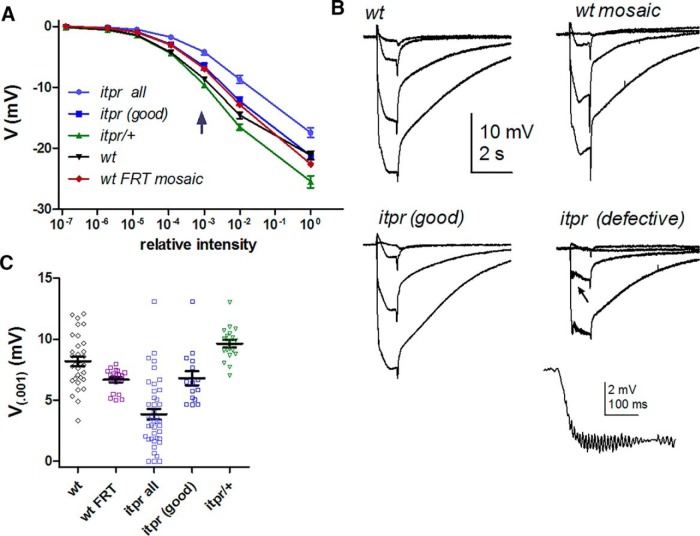
ERGs in itpr-null mosaic eyes. A, Response intensity (V/log I) functions measured from ERG (plateau at end of 1-s stimuli) in itpr-null mosaics (all flies, n = 40), selected itpr mosaics without obvious ERG defects (itpr “good,” n = 15), wild-type (n = 32), itpr/+ sibling controls (n = 18), and “wild-type” FRT mosaic eyes (n = 18). B, Representative ERG traces, including examples of a “good” and an obviously defective ERG from itpr mosaics: inset shows trace with oscillations (arrow) on expanded scale. C, Scatter plot of ERG amplitudes to relative intensity 10−3 (arrow in A). Overall, w+; itpr mosaic flies showed a significant reduction in amplitude (p ∼10−9 vs. wt, p = 0.0001 vs. wt FRT mosaic; two-tailed unpaired t test). If the obviously compromised recordings (V(0.001) <4 mV, oscillations and reduced synaptic transients) were excluded (itpr “good”), ERG amplitudes were still reduced compared with wild type and itpr/+ controls but now similar (p = 0.8) to recordings from wild-type mosaic eyes generated using an otherwise wild-type FRT82B chromosome (wt FRT).